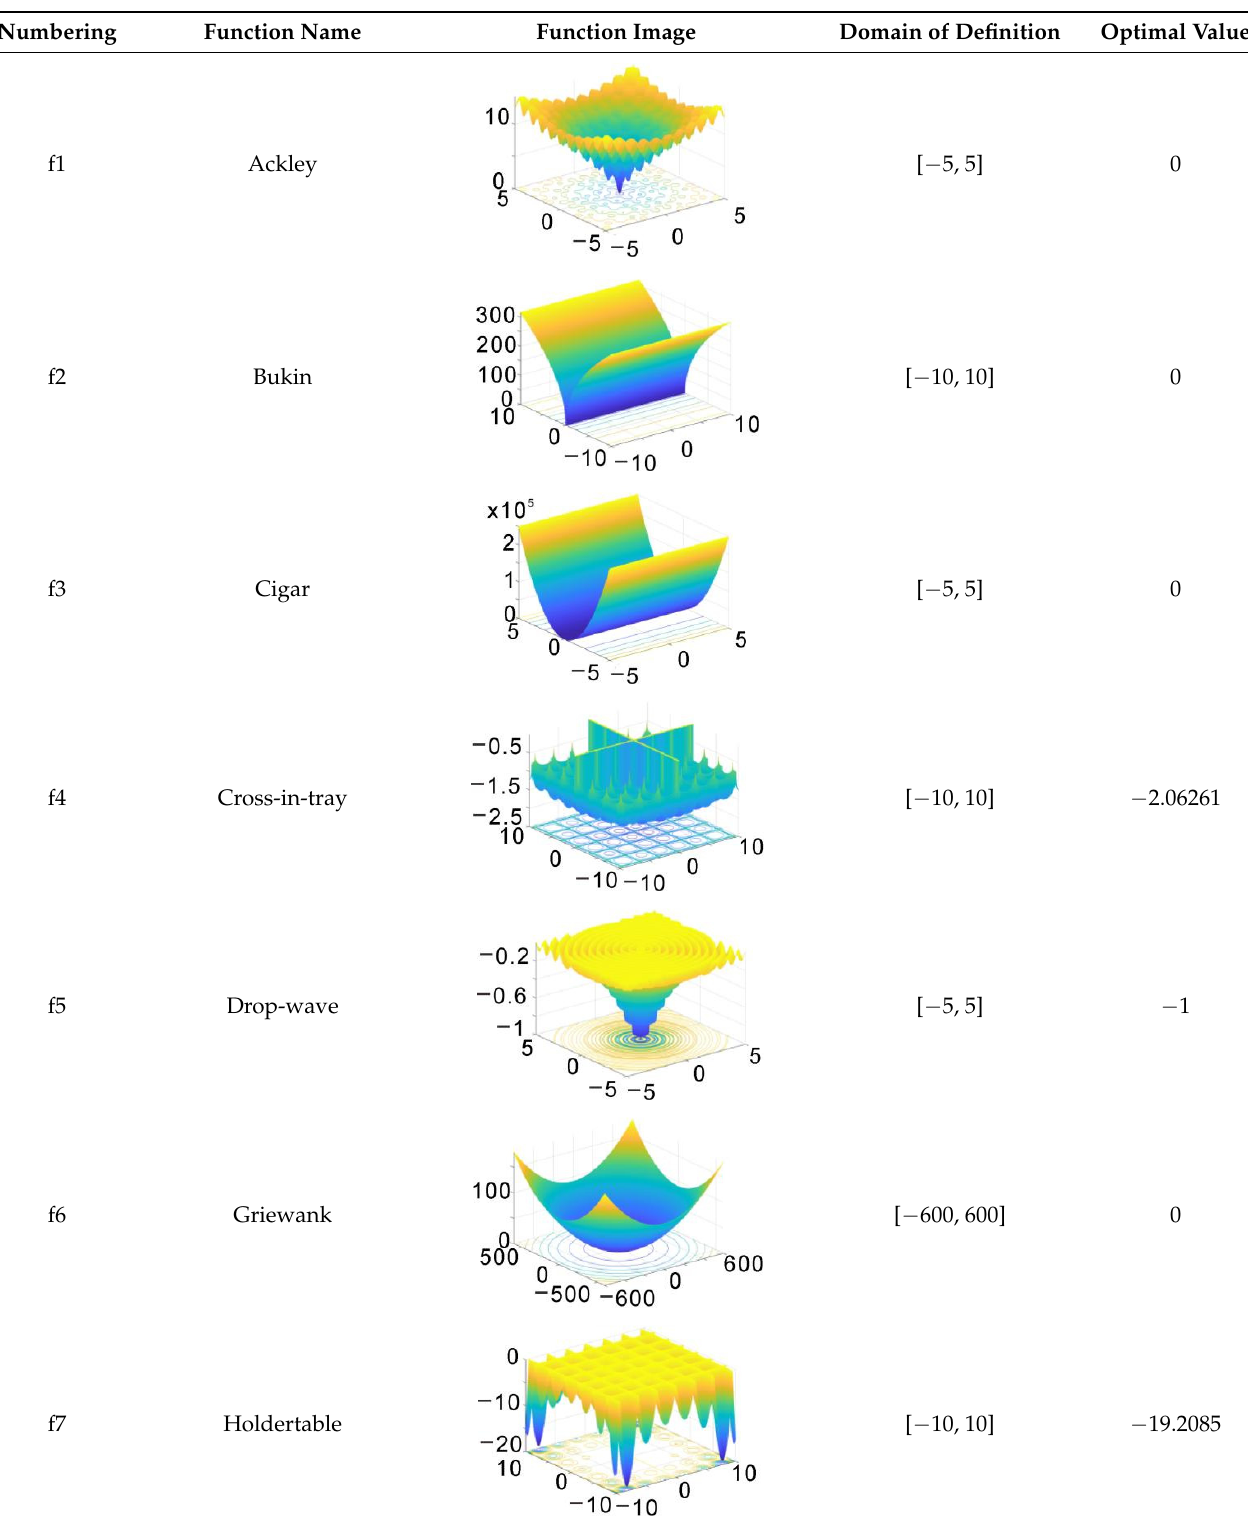
Table 1. Test Table 1. Test function. Table 1. Test function. Table 1. Test function. Table 1. Test function. Table 1. Test function.